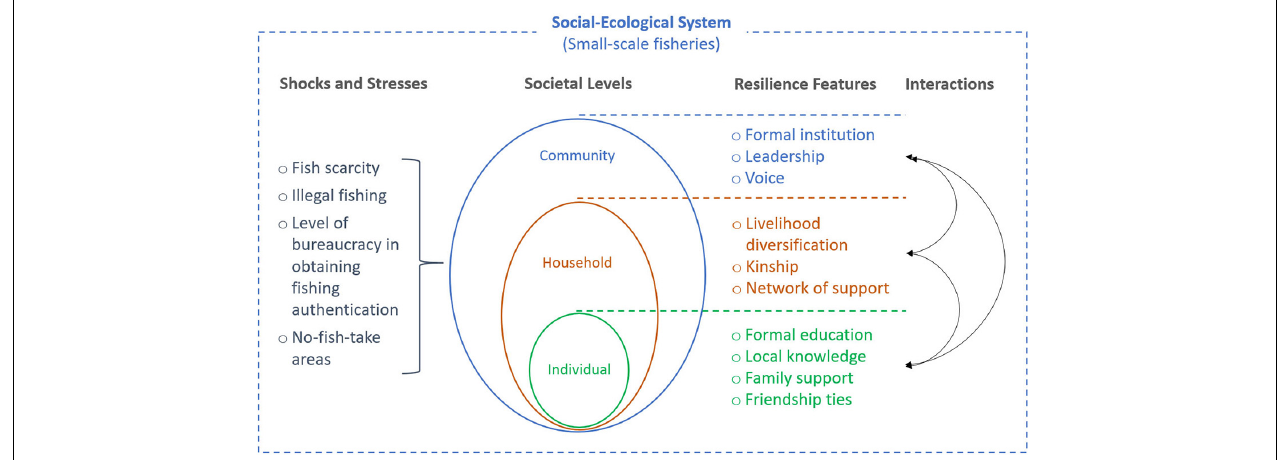
FIGURE 1 | Conceptual framework for the study [adapted the concept from Berkes and Ross (2016) and Leite et al.